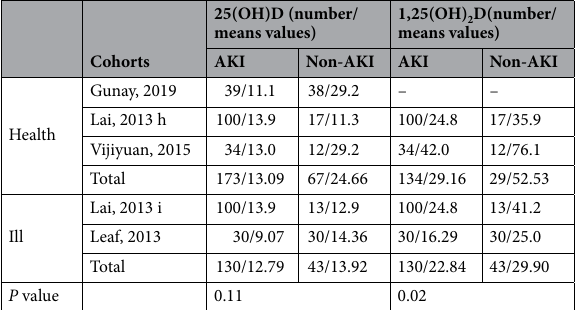
Table 3. The number and means values of the participants in subgroups.